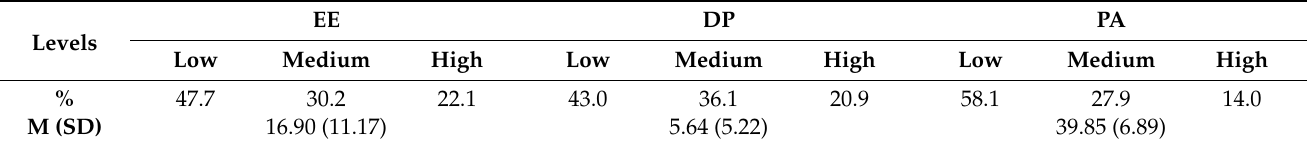
Table 3. Burnout levels for every single dimension.